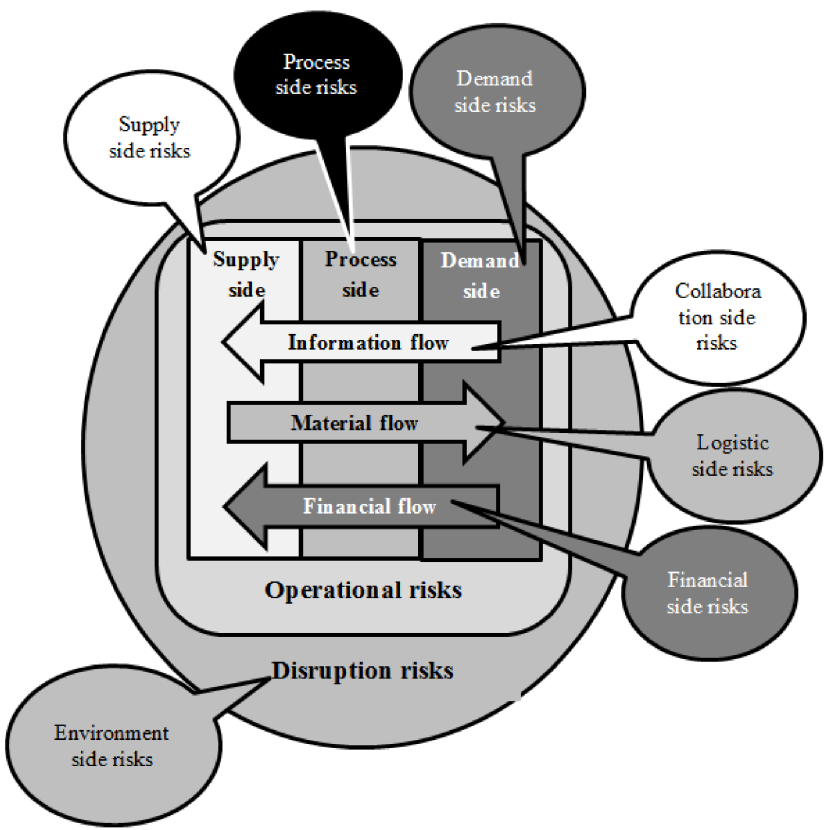
Figure 2. Distribution of all risks according to their sources (Musa,